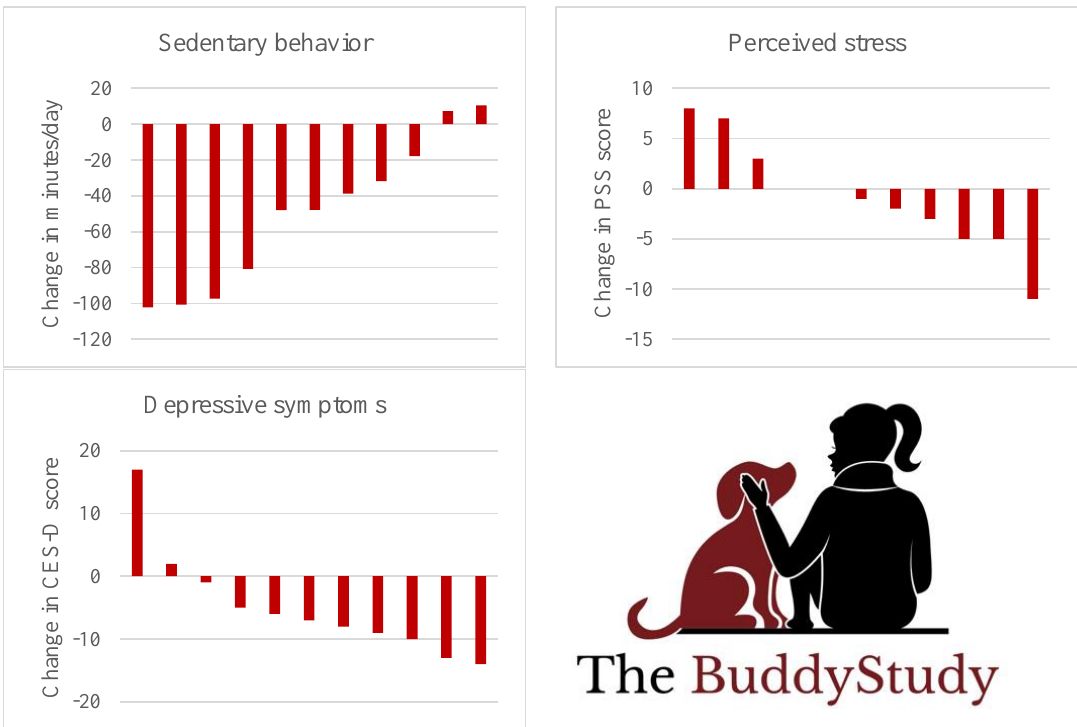
Figure 2. Individual participant changes from baseline to 6 weeks in physical activity, sedentary behavior, and psychosocial outcomes in the BuddyStudy (n = 11). Black bars indicate positive change is better; red bars indicate negative change is better. Physical activity and sedentary behavior were measured via ActiGraph accelerometer. Abbreviations: MVPA = moderate-to-vigorous physical activity; PSS = Perceived Stress Scale; CES-D = Center for Epidemiologic Studies- Depression scale.